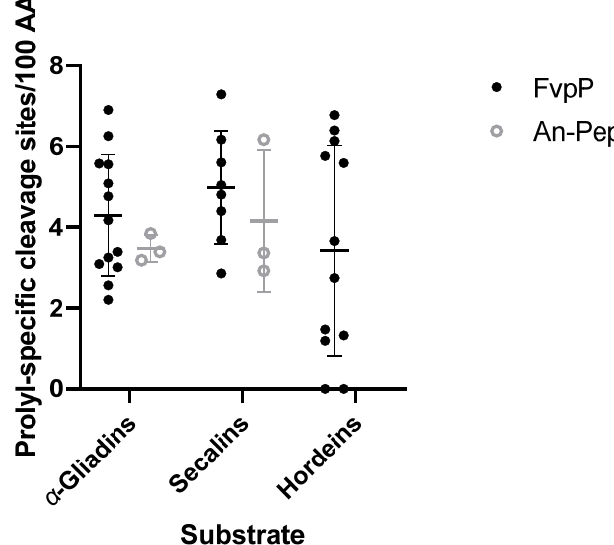
Figure 2. The number of prolyl-specific cleavage sites per 100 amino acids for α -gliadins, secalins and hordeins. Depicted is the mean with standard deviation as well as the individual values, as the number of samples differed significantly between the two endopeptidases. No hordeins were identified in the barley samples cleaved with An-Pep. The difference between the data sets was statistically